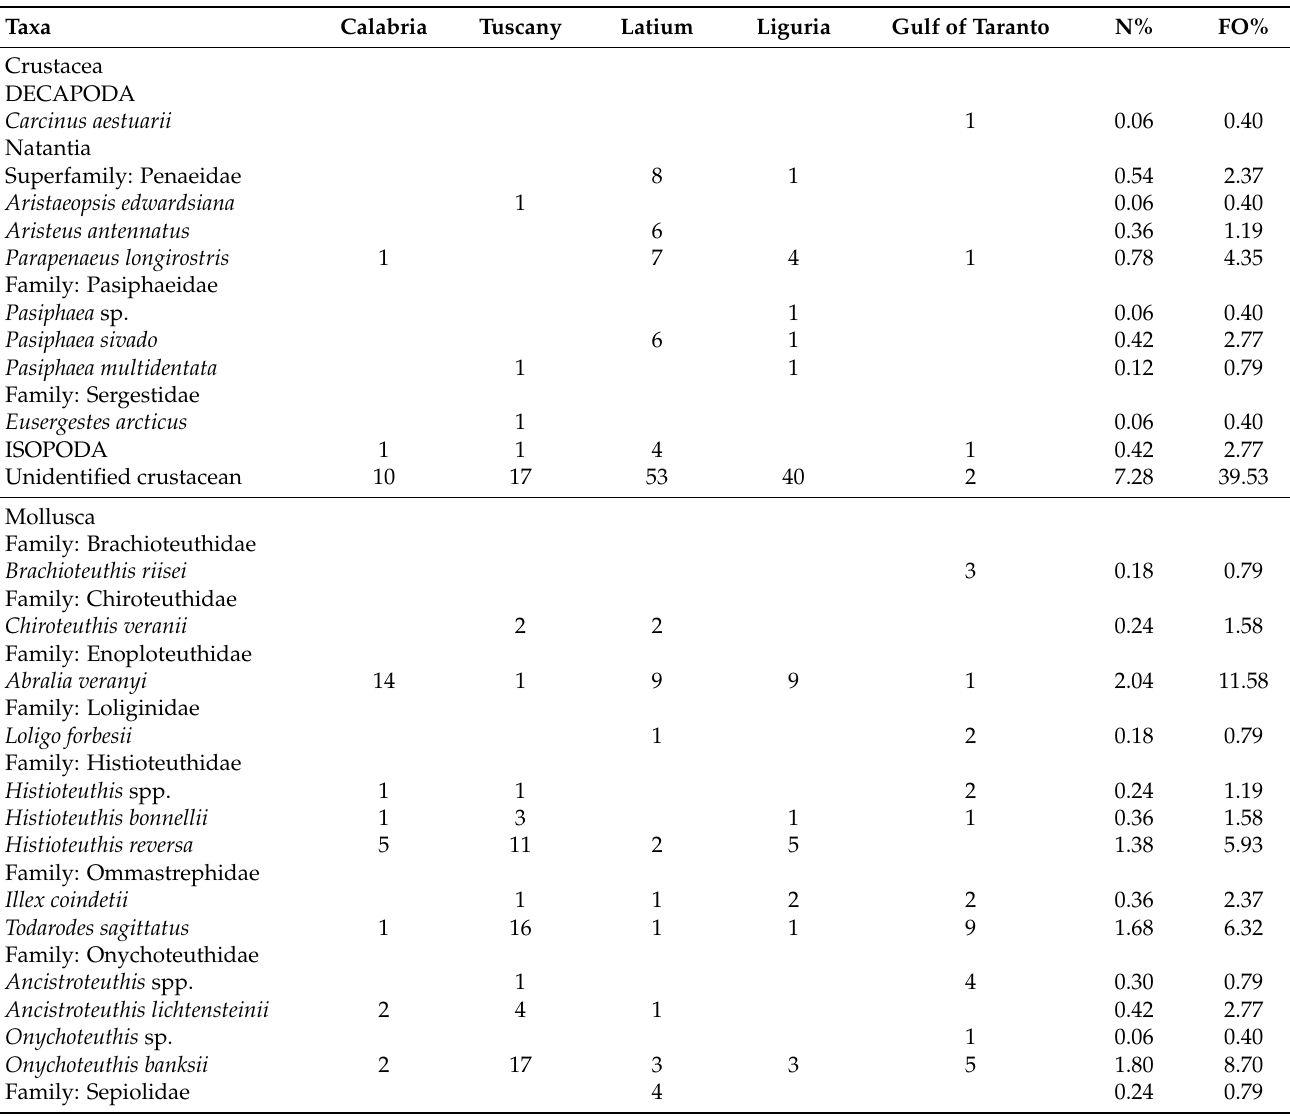
Table 2. Summary of all the species found in the stomach contents for each sampling area and the total N% and FO%. The number indicates how many items of that species were found in the stomach contents. The number of N% and FO% are in